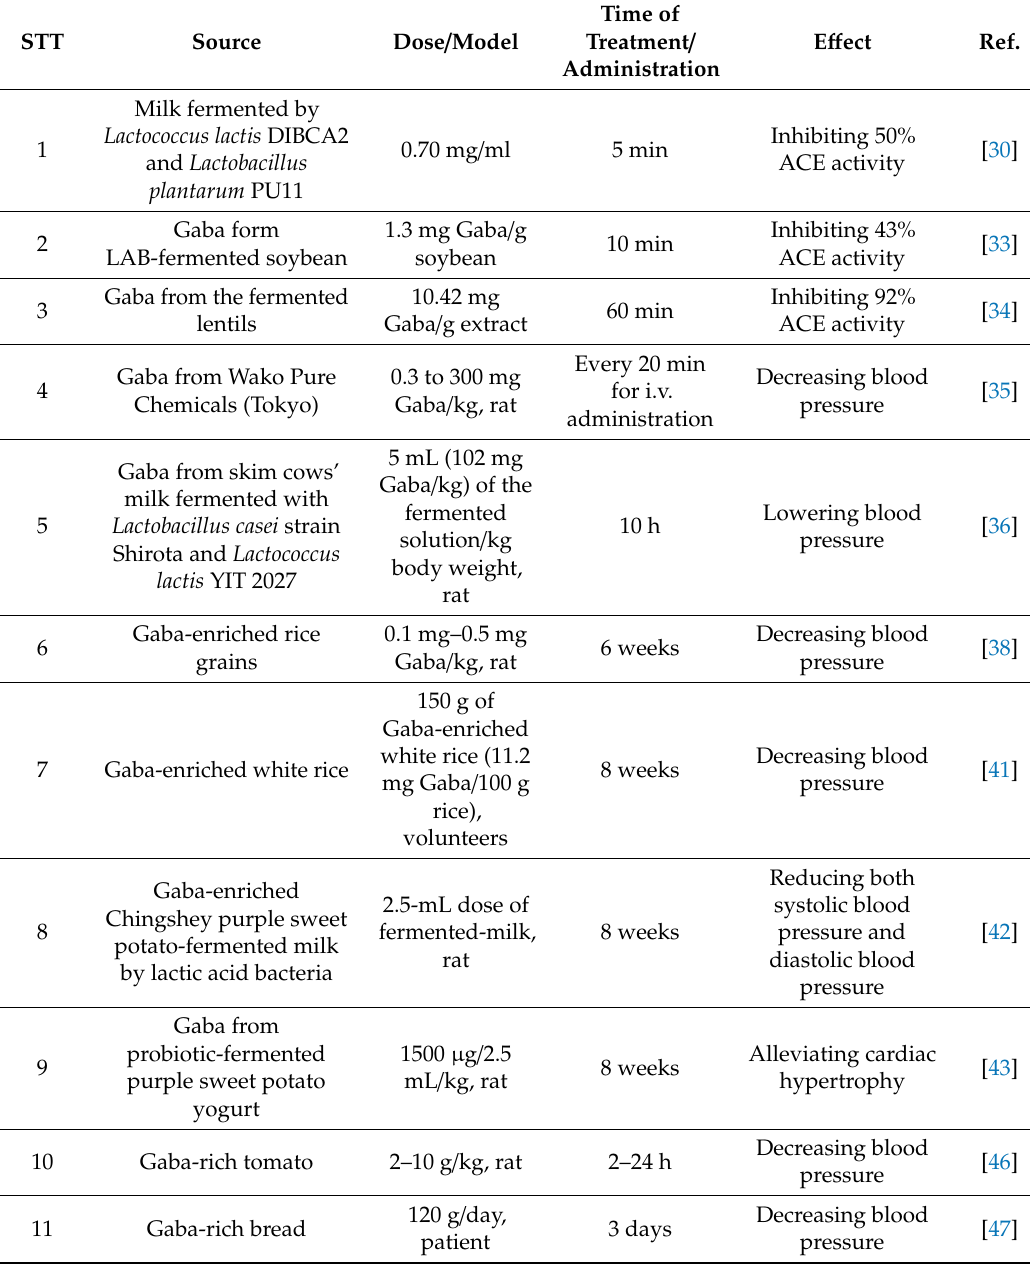
Table 3. Anti-hypertensive e ff ect of